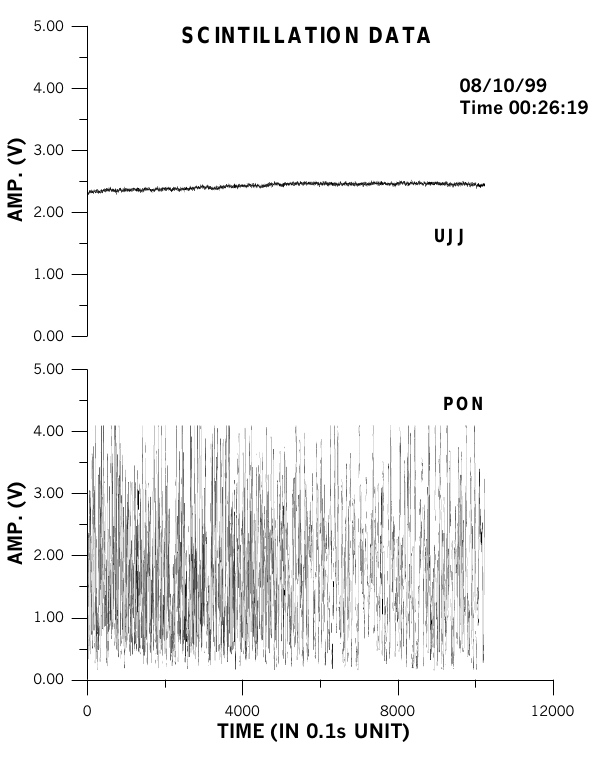
Fig. 5. Scintillations at the same time as specified in Fig. 4. The plot shows quite a significant scintillation at Pondicherry, whereas for Ujjain, the scintillations are not so significant.